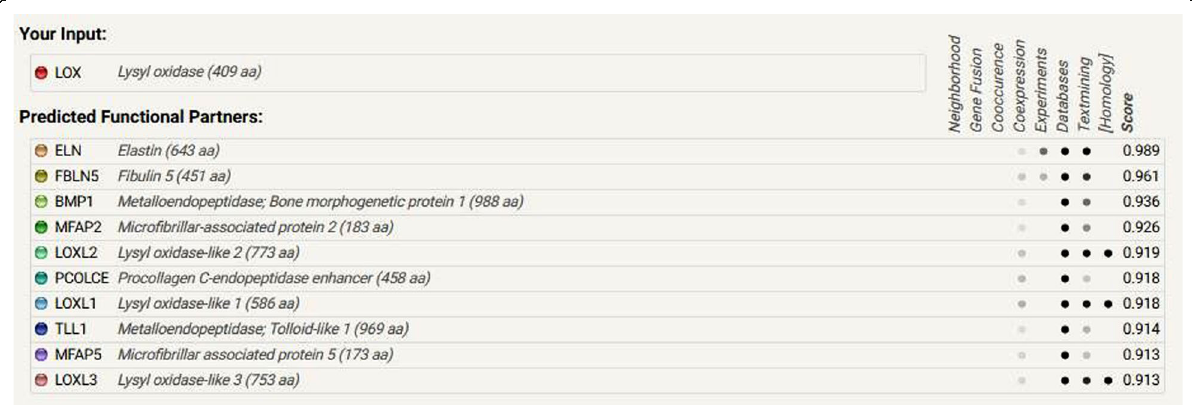
Fig. 10 Screenshot from STRING server of predicting interacting proteins with the query sequence. Top 10 interacting partners have been